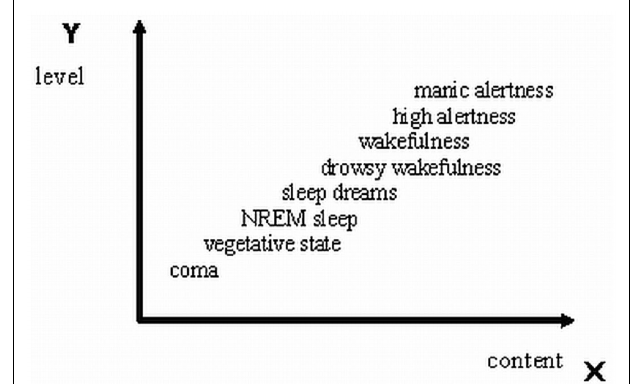
FIGURE 1 |A generic illustration of the traditional approach used for characterizing state-specific levels of consciousness (diagonal x = y ) by relating levels of wakefulness (as measured by objective psychophysiological and behavioral criteria typical for definite states; axis y ) and the concomitant variety of awareness content (as measured by subjective reports; axis x ).